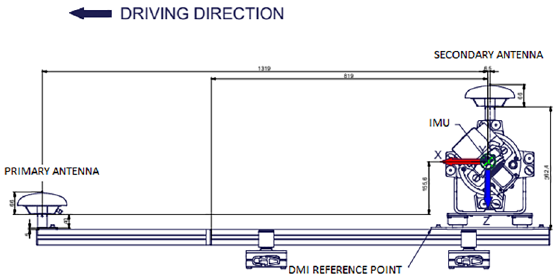
Figure 1. Riegl VMZ system two antennas, IMU placement and DMI reference point on the vehicle (Hybrid Mobile Laser Mapping System, 2014, p. 57)